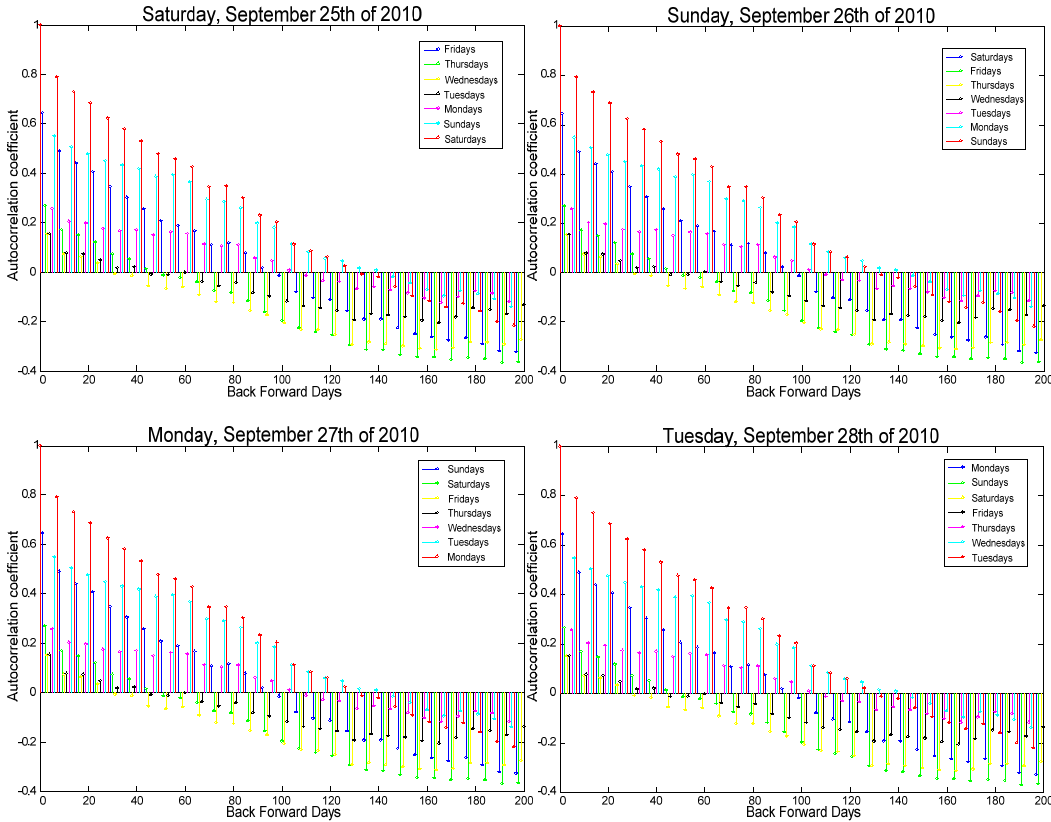
Figure 1. Autocorrelation coefficient for each of the days of the week with respect to all past patterns, arranged by day of the